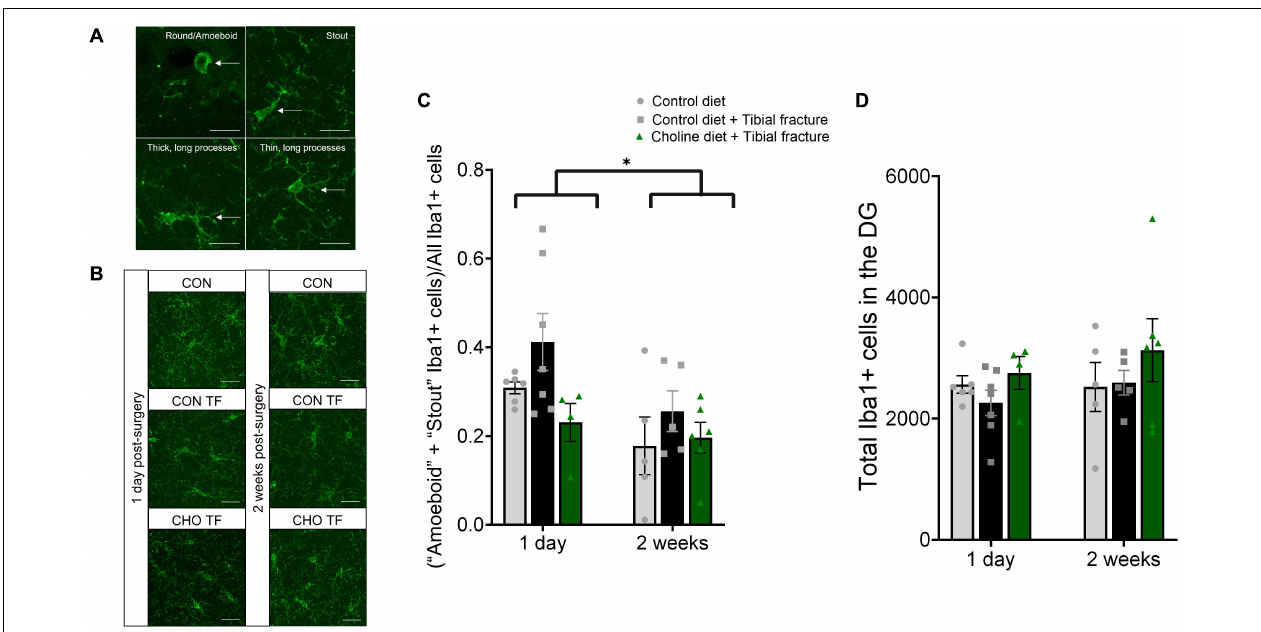
FIGURE 5 | (A) Representative images of each microglial morphology type quantified. Sections were immunostained with Iba1. Scale bar: 10 µ m. White arrows indicate each morphology type: round/amoeboid ( upper left ); stout ( upper right ); thick, long processes ( bottom left ); and thin, long processes ( bottom right ). Quantification states based on Schwarz et al. (2012). (B) Representative images of microglial morphology, represented as maximum intensity projections of the full Z-stack. Scale bar: 25 µ m. (C) Histogram showing the percentage of “round” + “stout” Iba1+ cells in the dentate gyrus of the hippocampus 1 day and 2 weeks after surgery. N = 4–7 per group. ∗ p < 0.05. (D) Tibial fracture and choline diet did not affect the total number of microglia. Histogram showing the total number of Iba1+ cells in the dentate gyrus 1 day and 2 weeks after surgery. N = 4–7 per group. Each bar represents the mean ±